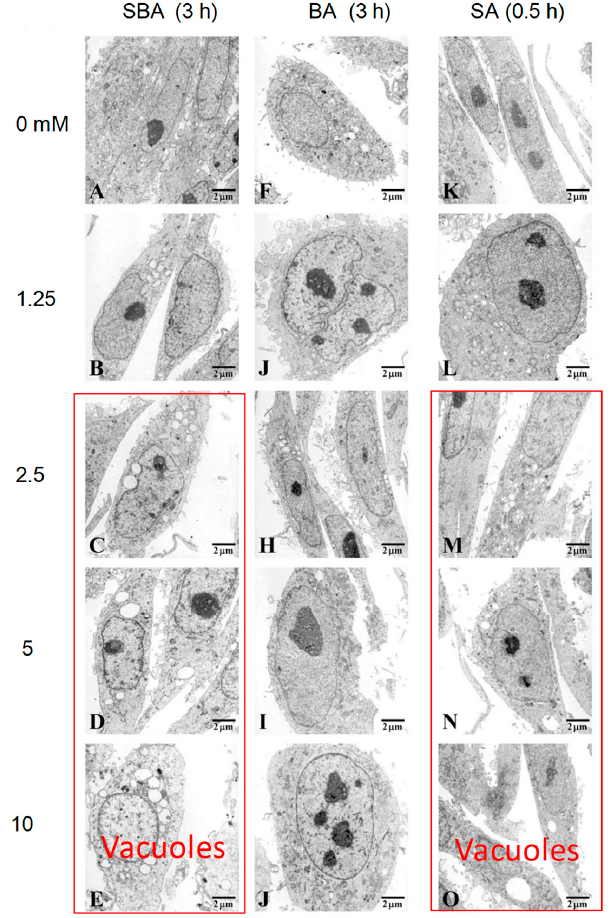
Figure 4. TEM analysis of fine cell structure of HSC-2 cells treated by the indicated concentrations of